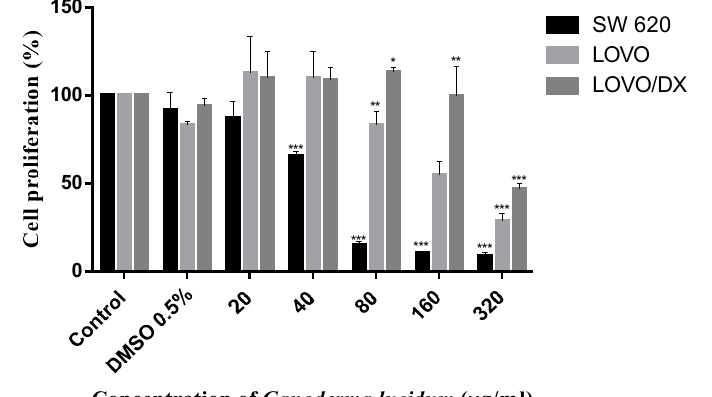
Figure 5. Antiproliferative effect of Ganoderma lucidum extract on MDA-MB-231, MCF7, and MCF7/DX after 72 h treatment. The results are the mean ± SD of three independent experiments. The significance of the differences was determined by Student’s t -test. * p < 0.05, ** p < 0.01, *** p < 0.001.